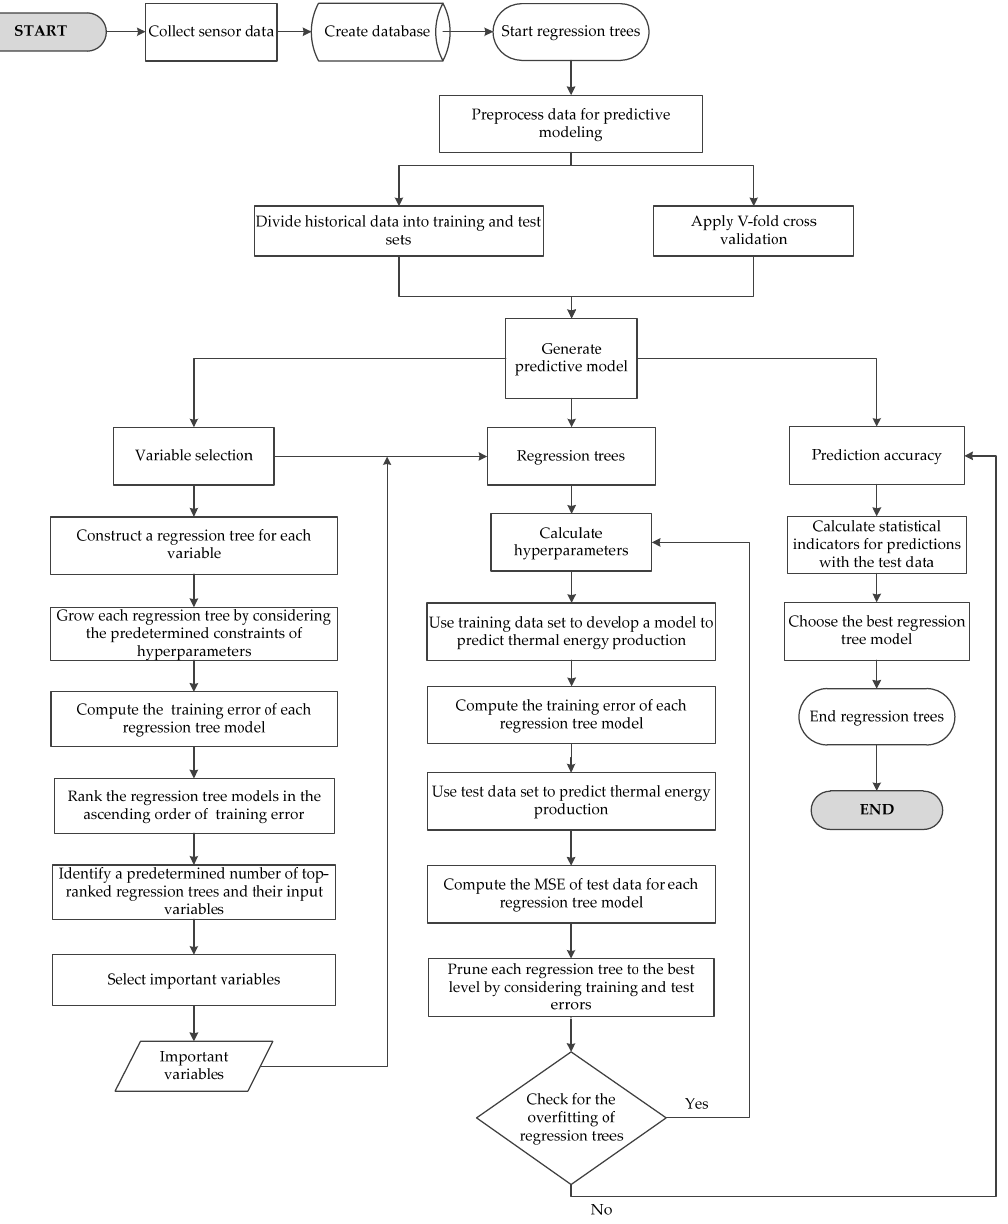
Figure 5. Flowchart of regression trees.